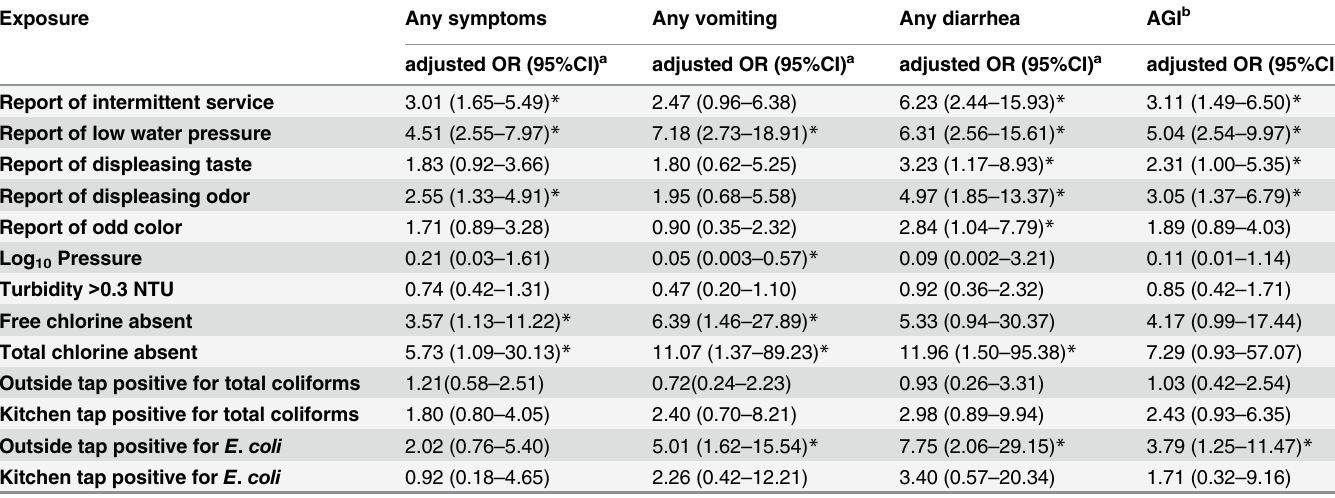
Table 5. Multivariable Associations between Reported Water Service Conditions, Measured Water Quality and Reported Health Outcomes in a Cross-Sectional Survey of Households in Rural Alabama in